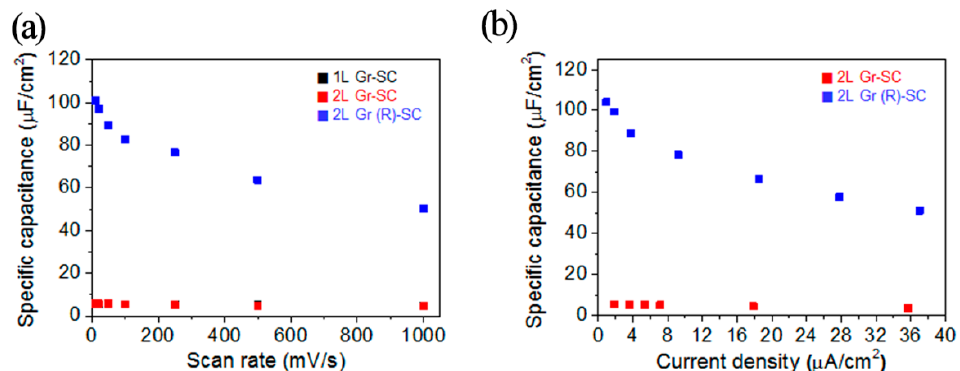
Figure 6. ( a ) The area-specific capacitances of 1L Gr-SC, 2L Gr-SC and 2L Gr (R)-SC calculated from the CV curves at the indicated scan rates. ( b ) The area-specific capacitances of 2L Gr-SC and 2L Gr (R)-SC calculated from the CD curves at the indicated current densities [71]. Copyright 2015, American Chemical Society